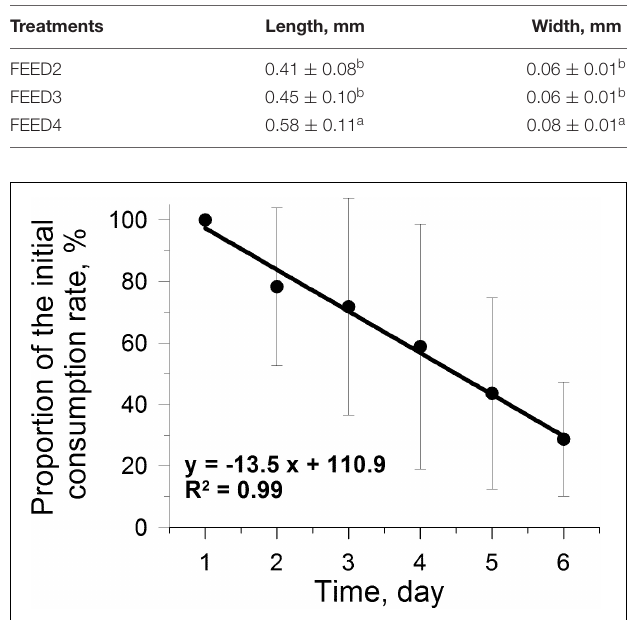
FIGURE 4 | Relative change in consumption rates of Calanus helgolandicus during 6 day experiment feeding on a mixture of microalgae Rhodomonas salina ( ∼ 5,000 cell ml − 1 ) and 6 µ m microplastics ( ∼ 5,000 beads ml − 1 ) ( P < 0.001).